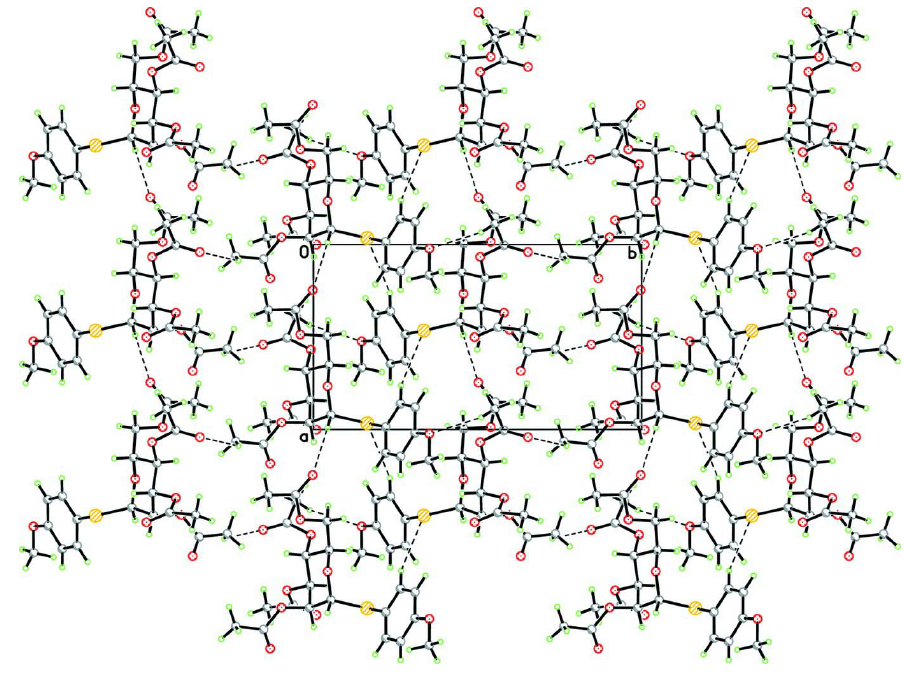
Figure 2 The molecular structure of 4-methoxyphenyl 2,3,4,6-tetra- O -acetyl-1-thio- α - D -mannopyranoside(I) drawn with probability ellipsoids drawn at 50%.